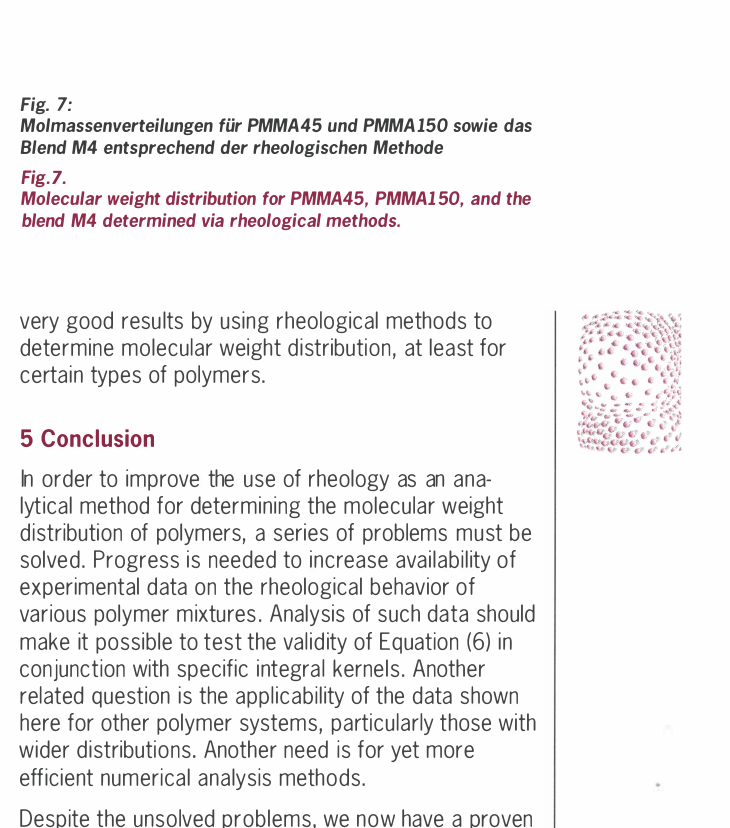
Fig. 7: Molmassenverteilungen fiir PMMA45 und PMMA150 sowie das Blend M4 entsprechend der rheologischen Methode Fig.l. Molecular weight distribution for PMMA45, PMMA150, and the blend M4 determined via rheological